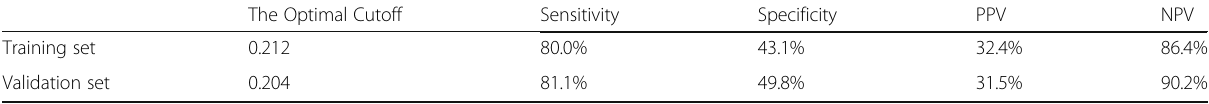
Table 4 Values of sensitivity, specificity, and predictive values of the predicted probability at the optimal cutoff value The Optimal Cutoff